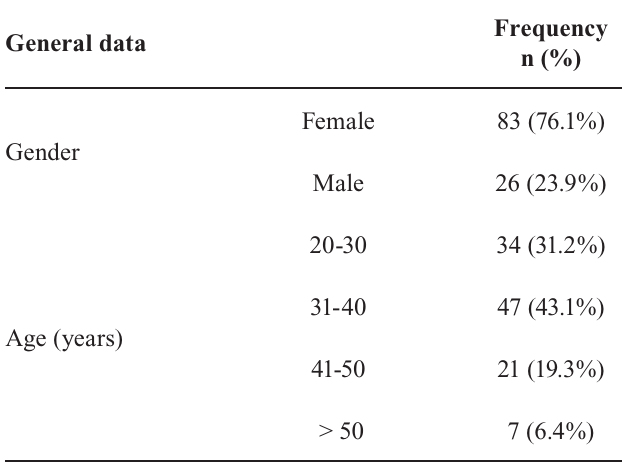
TABLE I - G eneral profile and academic background of pharmacists in charge of community pharmacies in the metropolitan region of Belo Horizonte-MG (n = 109; 2017) General profile and academic background of